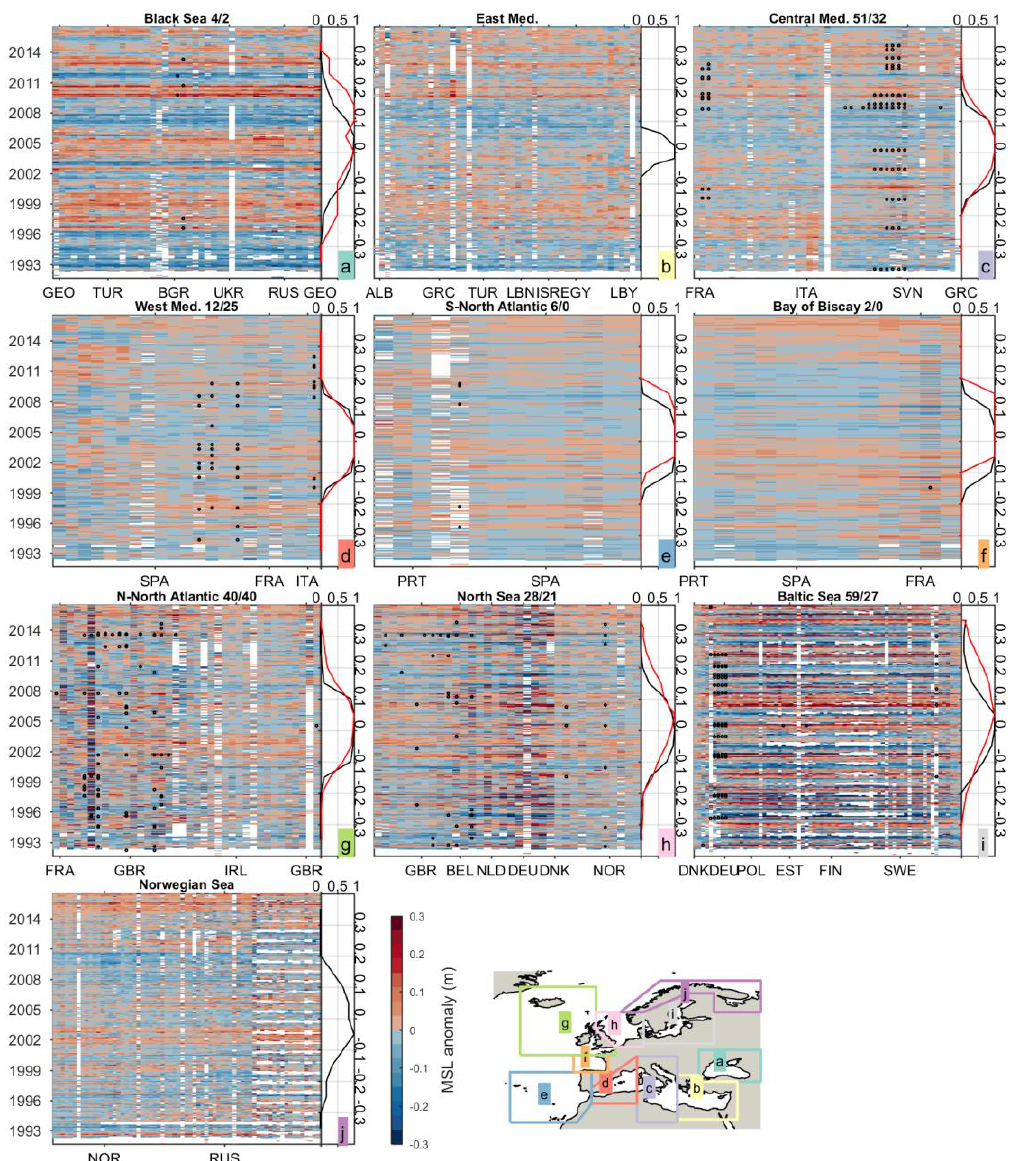
Figure 10. Monthly MSL anomalies along the European coastline (warm / cold colours indicate positive / negative MSL values) for each oceanographic region ( a – j ). The ratio of positive / negative anomalies for the CFEEs is also indicated. The ordinate axis represents the time and the abscissa axis represents the spatial variation along the coast indicated by ISO country code labels. Black dots indicate the date and position of extreme events registered in the database. The red line represents the relative frequency distribution of the monthly anomalies corresponding to the extreme events registered in the database and black line represents the spatially average of monthly anomalies distribution in the region.